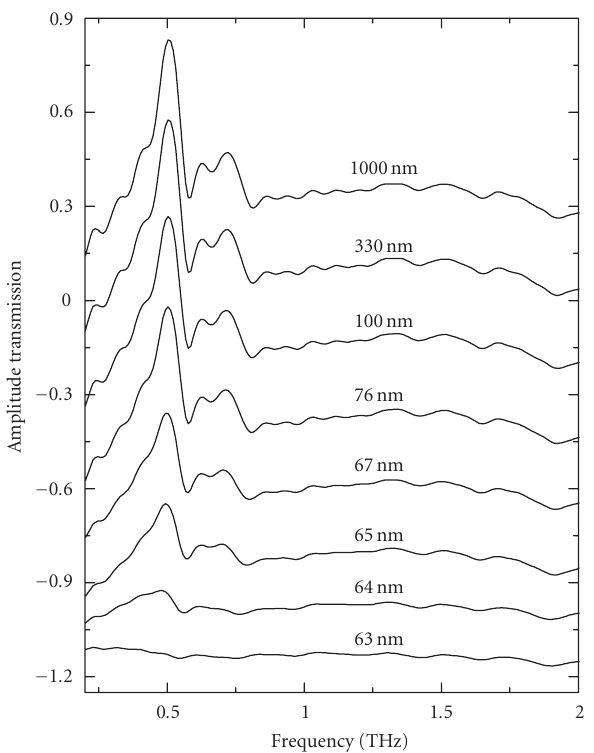
Figure 3: Amplitude transmission of terahertz pulses through the Pb arrays with di ff erent film thicknesses. The curves are vertically displaced for clarity.